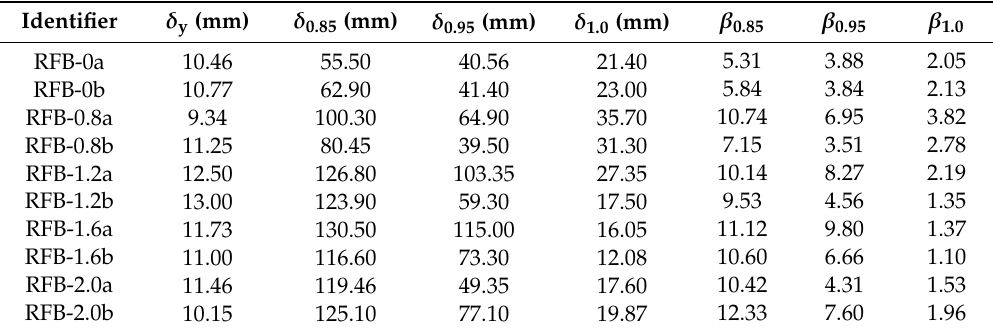
Table 5. Calculation results of flexural ductility index of the test